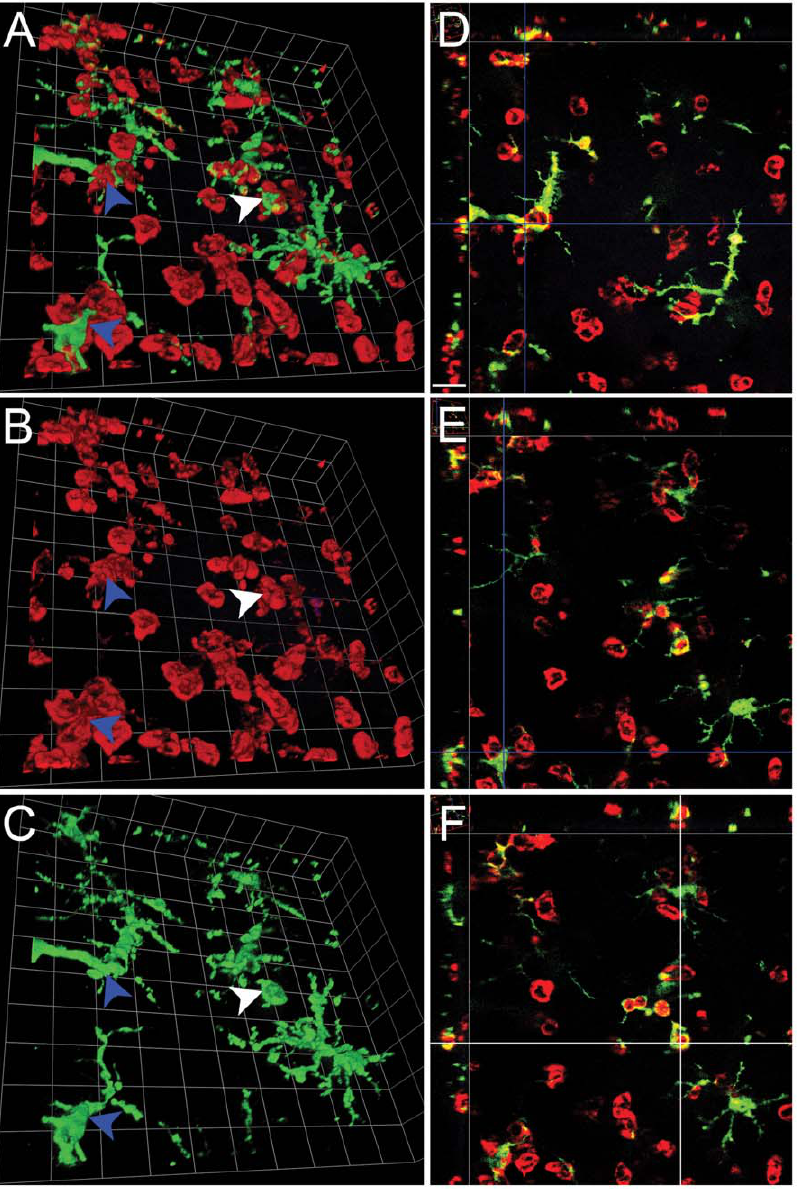
Figure 5. Stereotactic injection of Tat results in reciprocal engulfment of microglia and infiltrating leukocytes. Montage of higher magnification micrographs with 3D reconstruction of GFP + microglia (green) interacting with infiltrating CD11b + leukocytes (red) in the right hippocampus of mice injected with Tat 24 hours earlier (Panels A, B, and C) and XYZ views at different depths of the same image stack (Panels D, E, and F). Blue arrowheads points to the corresponding locations where infiltrating leukocytes engulf microglia processes. Panel A shows a combined view of CD11b (red) and GFP (green) expression, while panel B shows CD11b expression alone and panel C shows GFP expression alone. The white arrowhead points to the location where GFP + microglial processes phagocytose a CD11b + infiltrating leukocyte. To further illustrate the phagocytic nature of these cell-to-cell interactions, Panels D and E show the corresponding XYZ view of the location (the crossing point of the two blue cursor lines) of the top and bottom blue arrowhead in panel A, respectively. Panel F shows the XYZ view of the location (the crossing point of the two white cursor lines) of the white arrowhead in Panel A. Each side of individual grids=14 m m for Panels A–C, and the scale bar shown in Panel D=16 m m for D–F. n=3 independent replicates for Tat treatment.